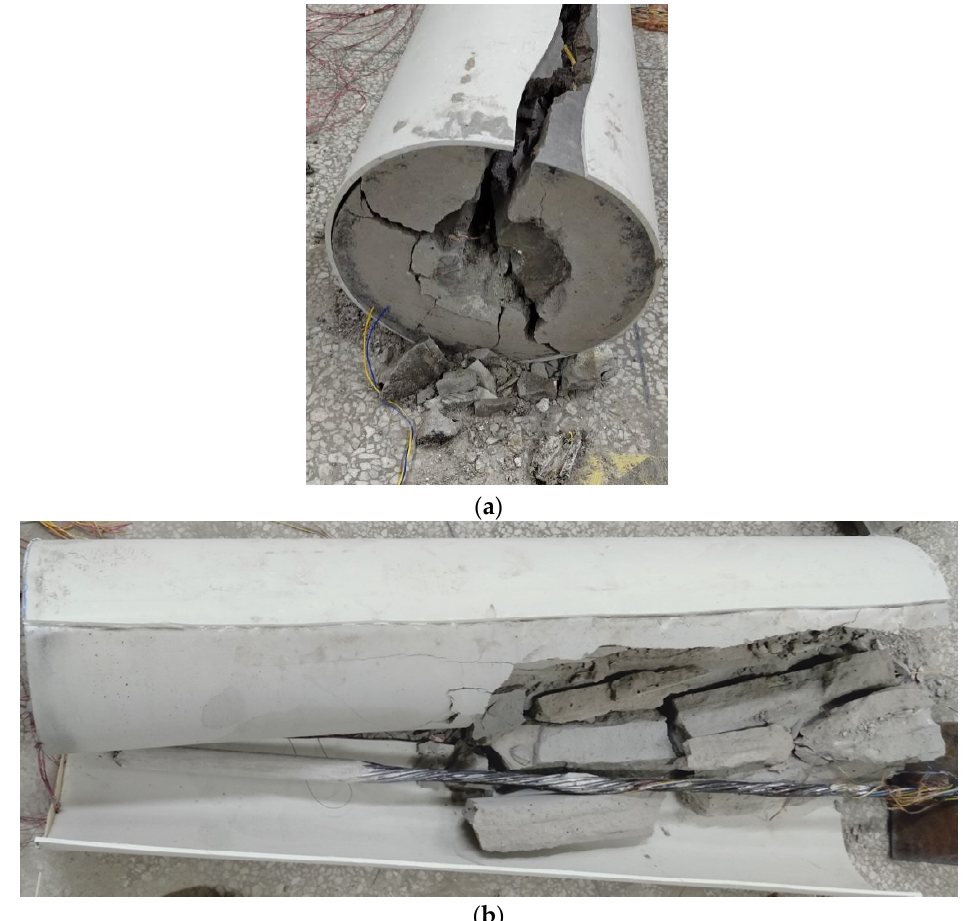
Figure 9. Failure of the anchoring structure. ( a ) Cross section; ( b ) Longitudinal section.